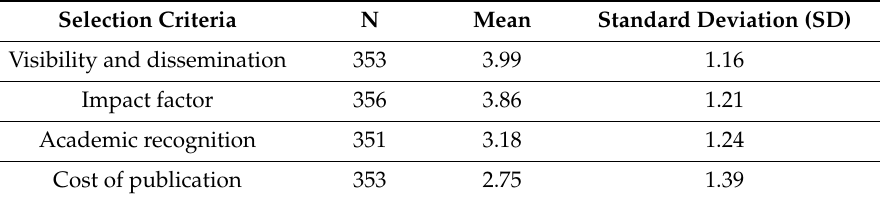
Table 2. Assessment of the selection criteria of an Open Access medical journal.